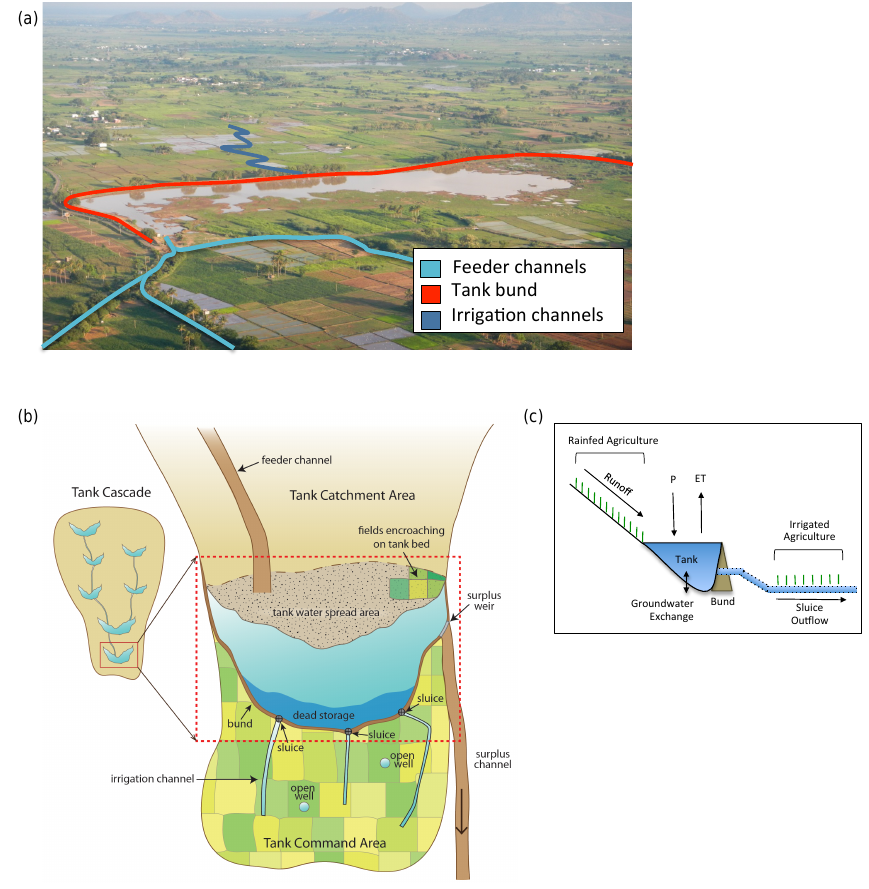
Figure 2. (a) Aerial view of Tank 4 in the Thirumal Samudram cascade; (b) plan view of a typical tank along with catchment and command area (Van Meter et al., 2014); (c) cross section showing tank water budget components. Table 2. Summary of tank attributes based on historical tank data and the current study. Current tank capacity is based on our measurements, while historical tank capacity is based on Public Works Department data (DHAN, 2010).